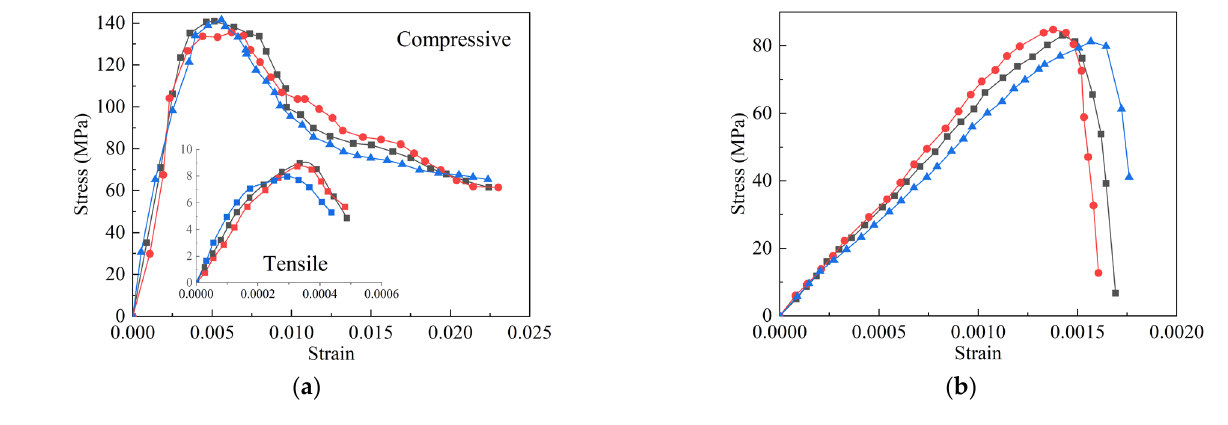
Figure 5. The stress-strain curve; ( a ) UHPC; ( b ) NC. Table 1. Strength of the tested specimens.